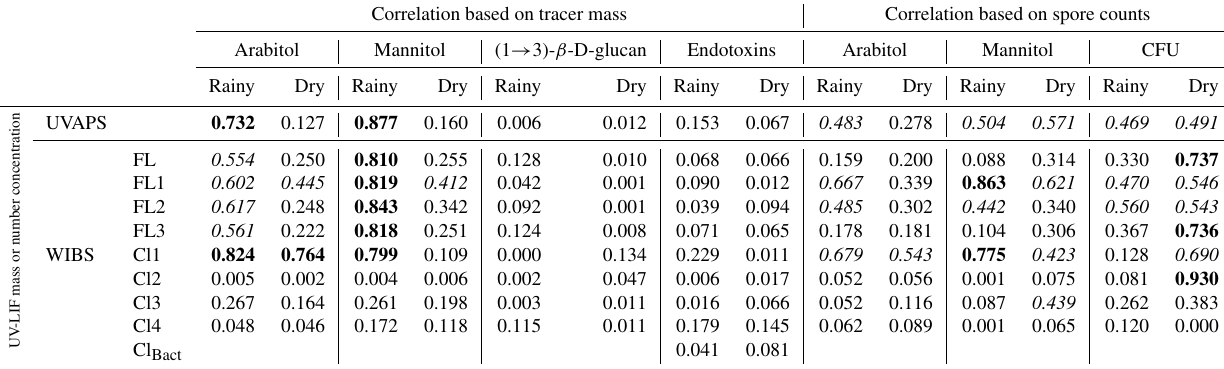
Table 3. Square of correlation coefficients ( R 2 ) comparing fluorescent particle measurements from UV-LIF instruments to measurements from molecular tracers and direct-to-agar sampler. Columns marking tracer mass indicate correlations between time-averaged UV-LIF and tracer mass concentrations (left side). Columns marking fungal spore count indicate correlations between fungal spore number concentrations estimated from time-averaged UV-LIF and tracer or culture measurements (right side). FL1, FL2, FL3 represent individual channels from the WIBS. FL represents particles exhibiting fluorescence in any channel. Cl1, Cl2, Cl3, Cl4 are clusters that estimate particle concentrations as a mixture of various channels (Crawford et al., 2015). Cl Bact is a sum of the “bacteria” clusters Cl2-4. Boxes colored by coefficient value ( bold >0.7; 0.7 > italic